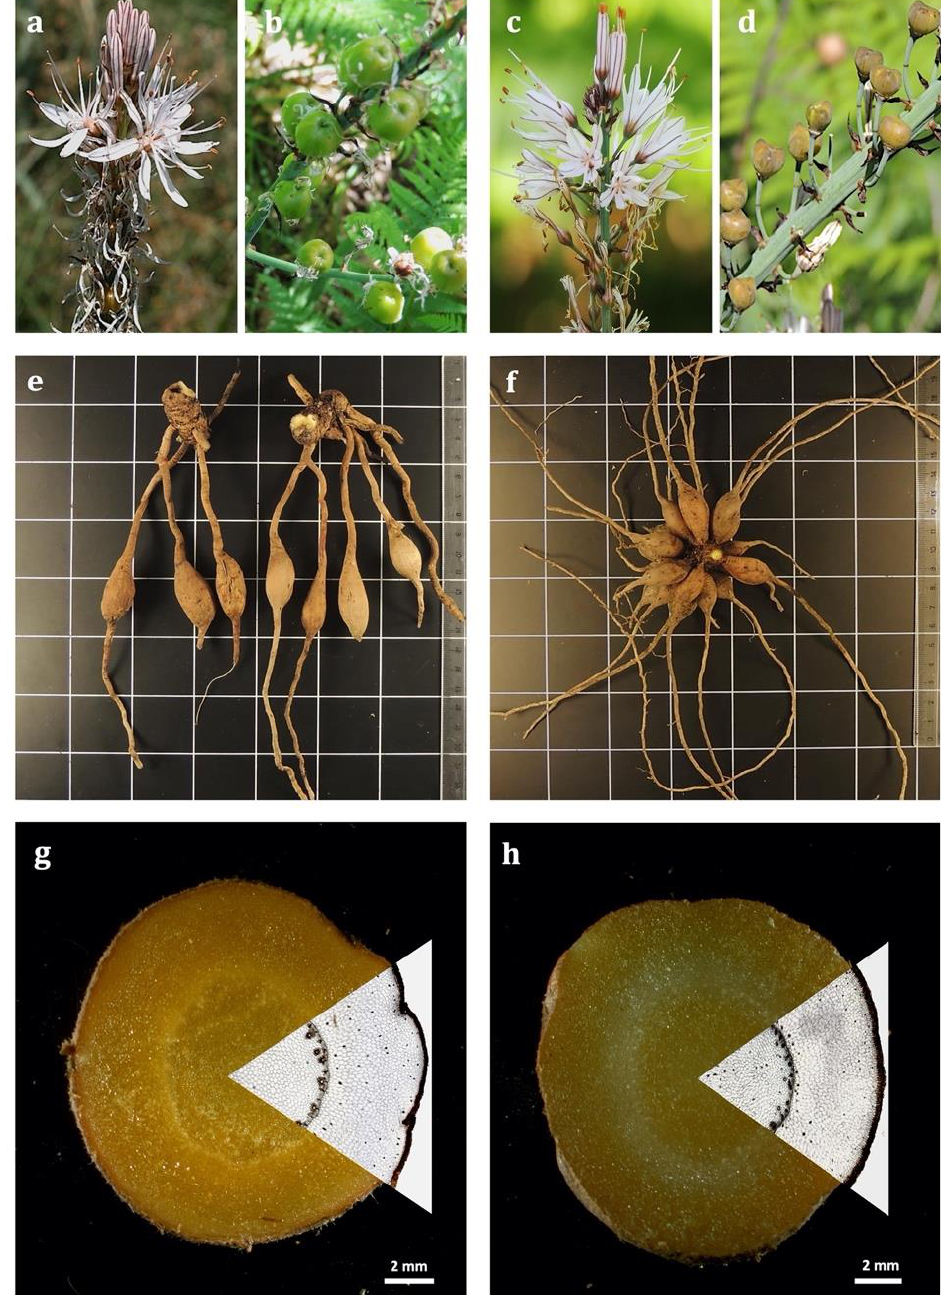
Figure 1. Macroscopic features of Portuguese Asphodelus species. Images of flowers and fruits of A. macrocarpus ( a , b ) and A. bento-rainhae ( c , d ) growing in their natural habitats, Serra da Gardunha, Fund ã o. Root tubers in general and cross-section views in A. macrocarpus ( e , g ) and A. bento-rainhae ( f , h